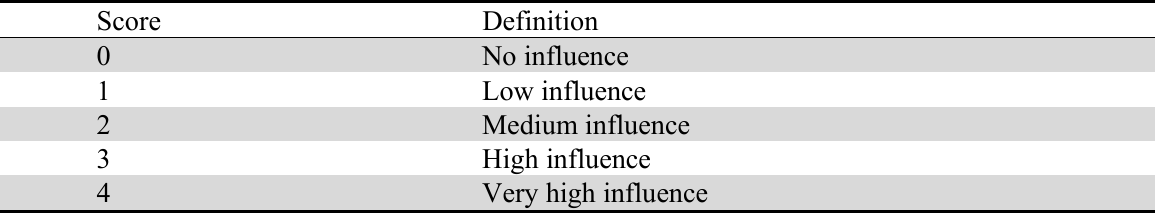
Pair-wise comparison